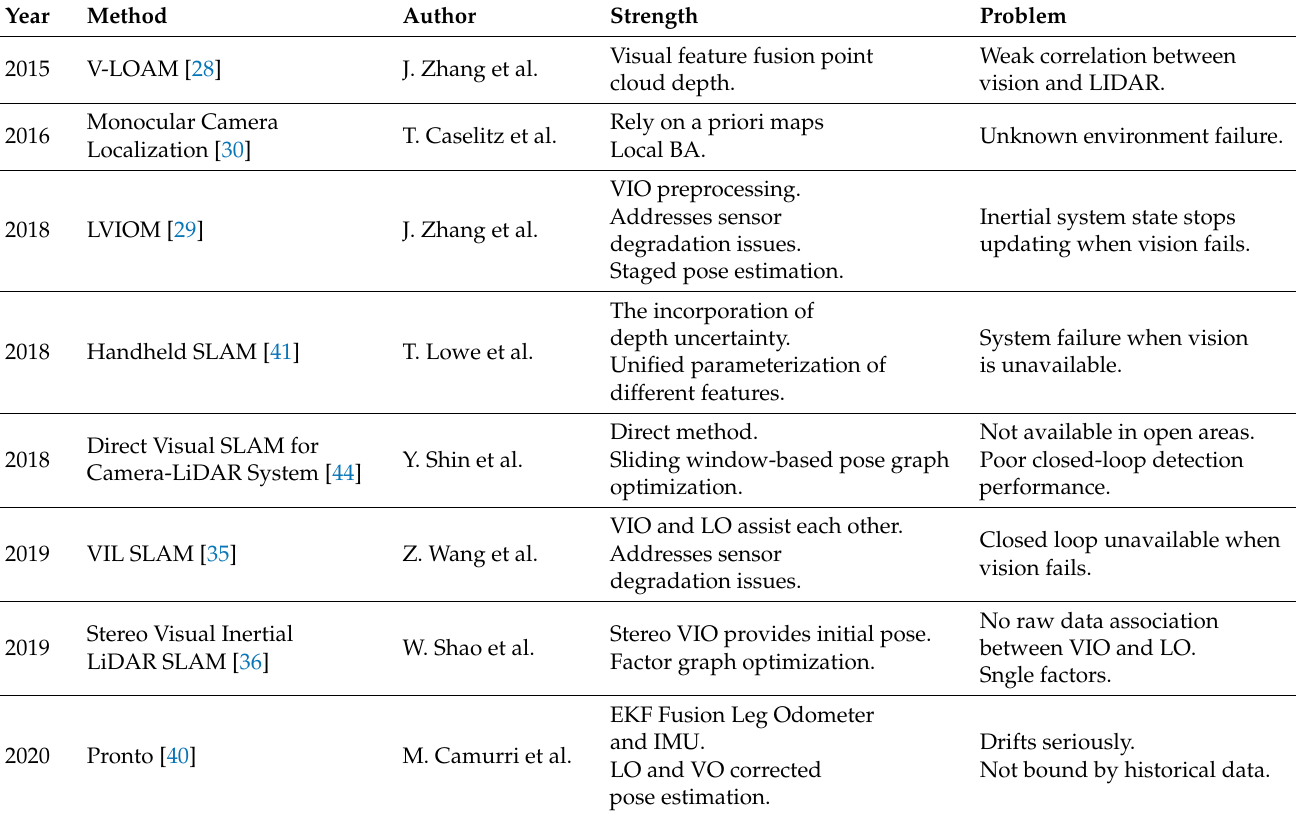
Table 3. LVI loosely coupled